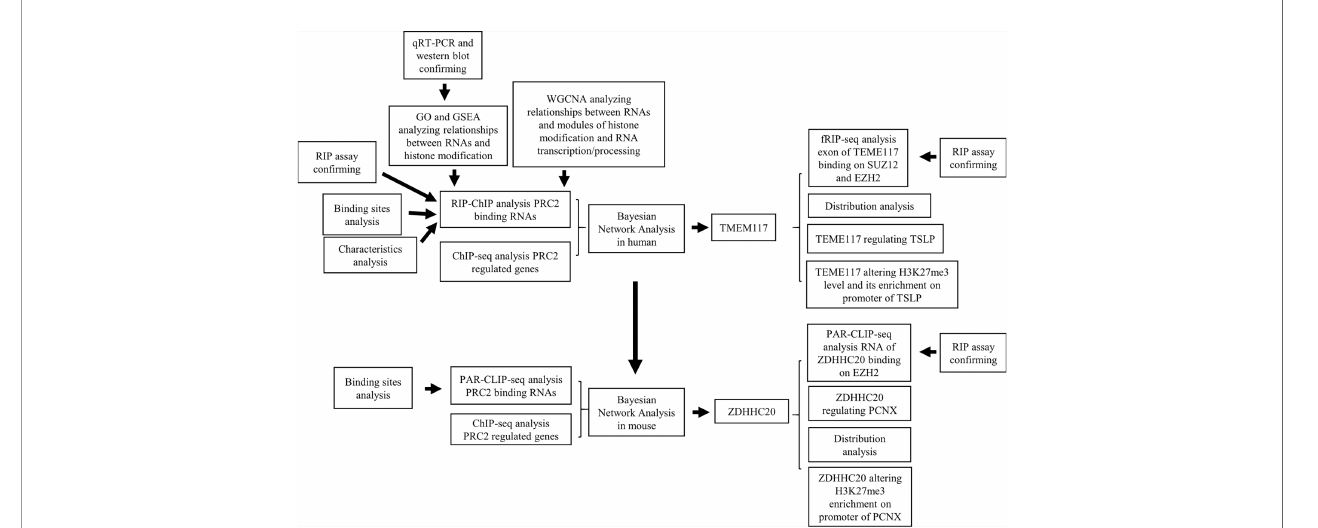
FIGURE 8 | The work fl ow of this